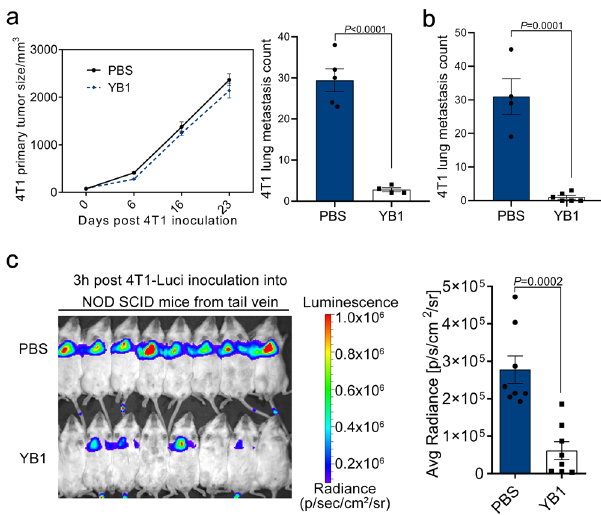
Fig. 4 The innate immune responses are suf fi cient for Salmonella YB1 to inhibit cancer metastasis. a Quanti fi cation of 4T1 primary tumor size and relevant lung metastases (two-tailed unpaired t -test) after YB1 treatment ( n = 4) in the 4T1-NOD SCID orthotopic metastasis model. PBS as a control treatment ( n = 5). b Quanti fi cation (two-tailed unpaired t -test) of 4T1 lung metastases in the 4T1-NOD SCID experimental metastasis model with YB1 treatment ( n = 4 for PBS group; n = 6 for YB1 group). c Tracking and quanti fi cation (two-tailed unpaired t -test) of 4T1-Luci cells in vivo by luciferase live imaging 3 h after i.v. injection of 4T1-Luci into NOD SCID mice pretreated 3 days in advance with either PBS or YB1 ( n = 8 mice per group). The surface intensity of bioluminescence was measured with the region of interest (ROI) tools from Living image 4.0 software. All data are presented as mean values ± SEM. All displayed are one representative experiment of two independent experiments. Source data are provided as a Source Data fi